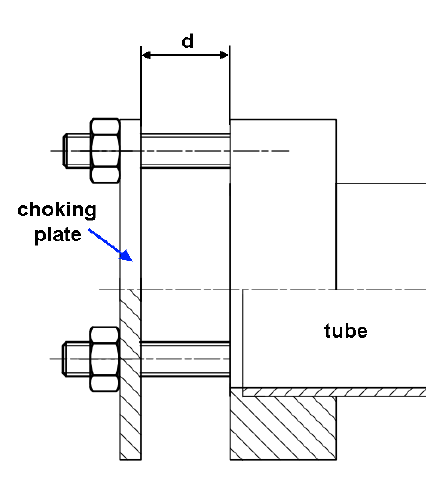
Figure 6: Choke valve design.